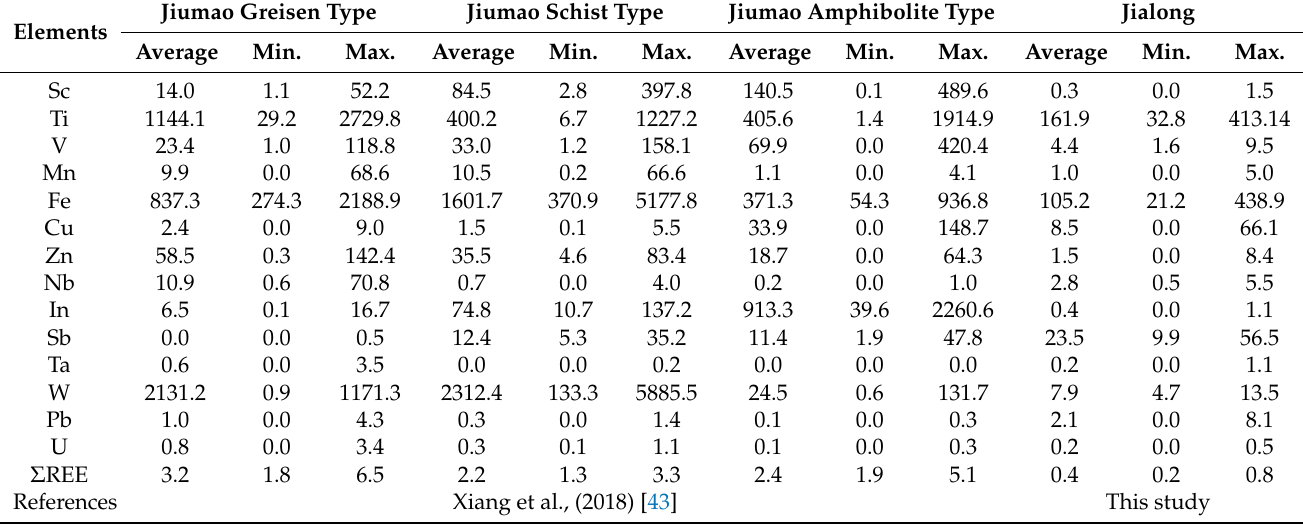
Table 3. Comparison of cassiterite trace element contents for the Jialong Sn–Cu and